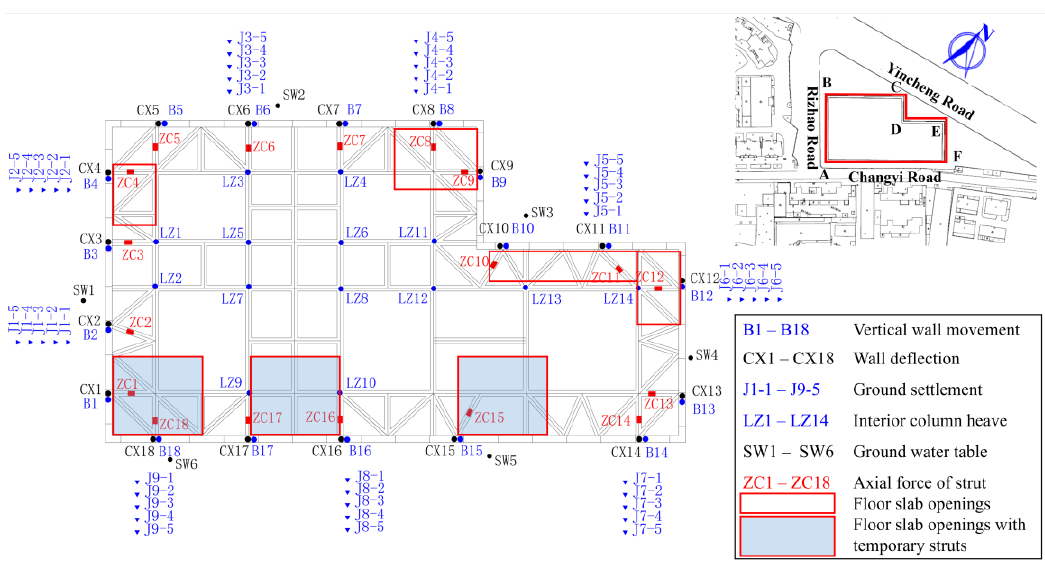
Figure 1. Site plane and instrumentation layout of the project.